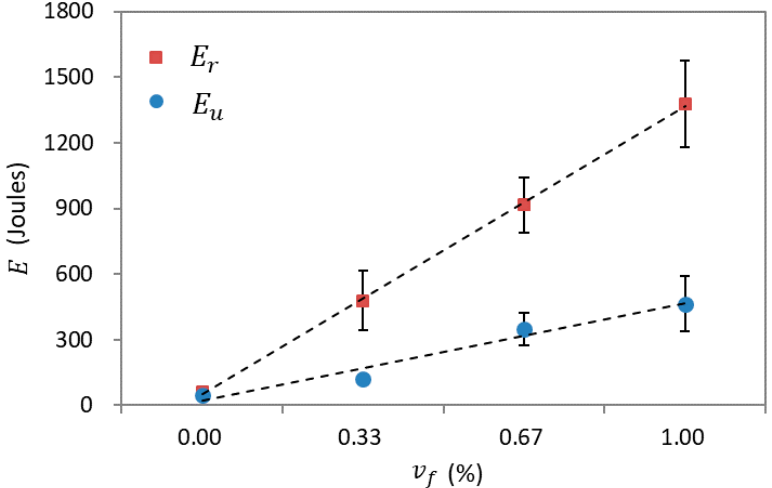
Figure 12. Energy absorption capacities E u and E r of the anchors in the plain concrete and SFRC with increasing fiber volume percentages from zero to 1.00%.